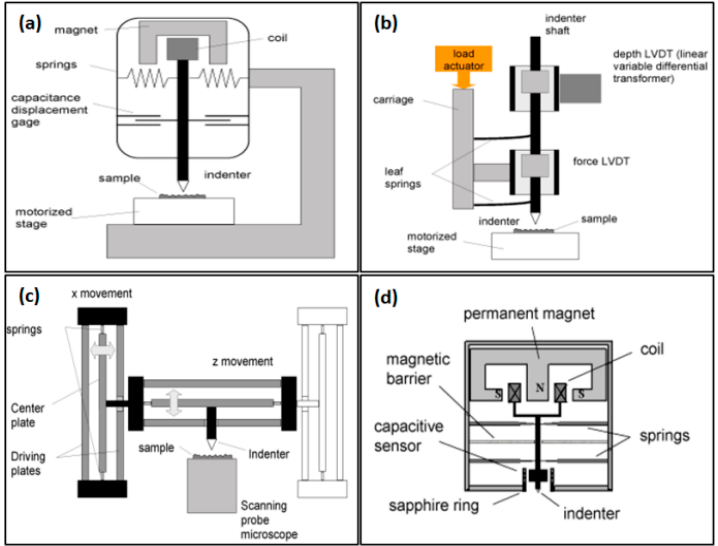
Figure 3. Sketches of the representative indentation instruments: ( a ) Nano-Indenter; ( b ) The Ultra- Micro-Indentation System (UMIS); ( c ) TriboScope; ( d ) The Nano-Hardness Tester (NHT) [15].